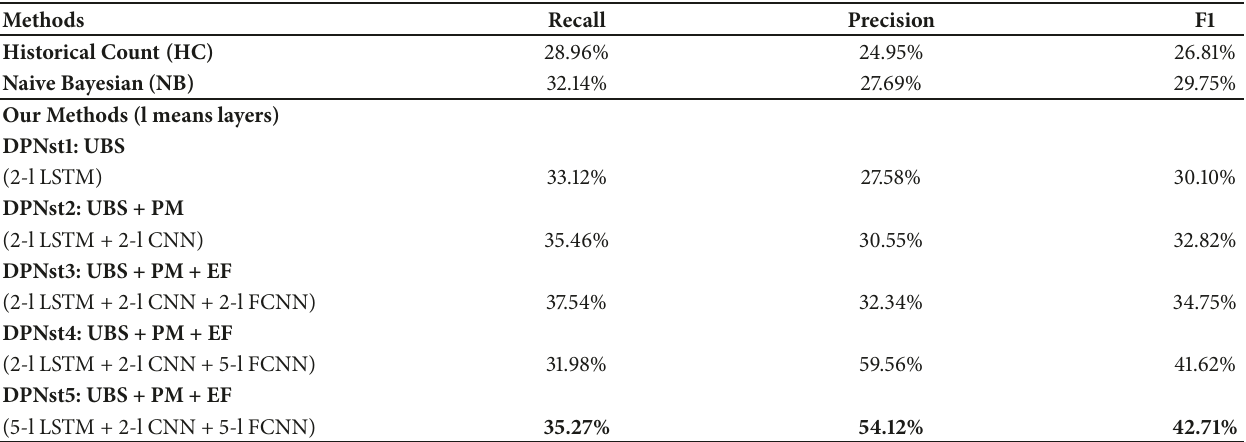
Table 7: Results for different methods of destination prediction.